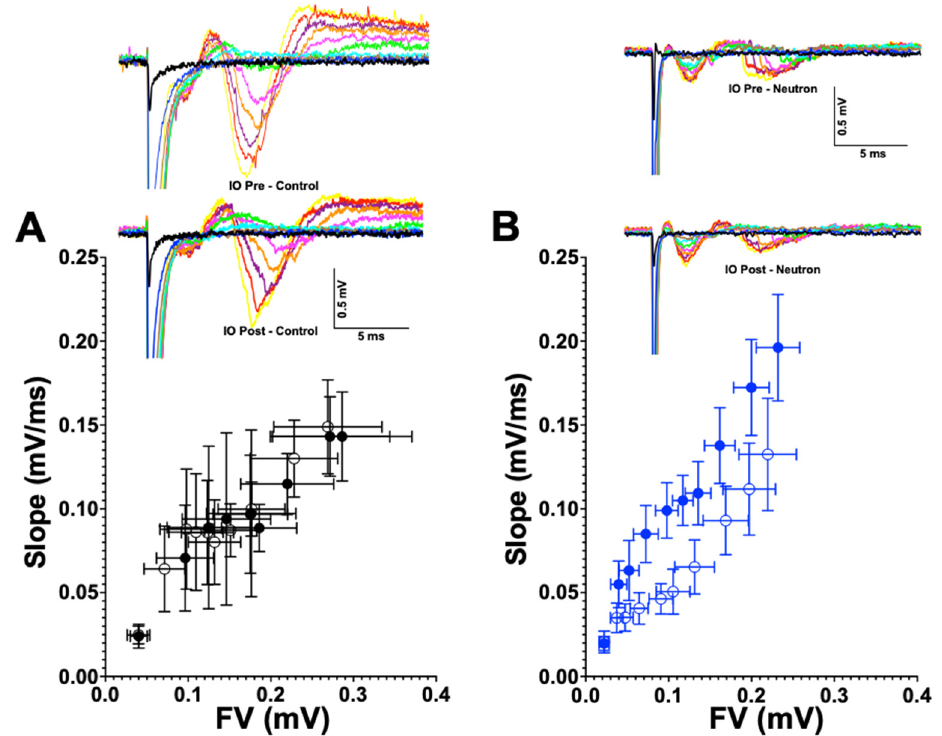
Figure 9. Input-output curves are not altered between the control and the chronic low dose neutron-irradiated group. ( A ) Pre-(filled circles) and post-LFS input-output relationships (clear circles) for the control group are plotted as a function of slope (mV/ms) on the y-axis and the fiber volley (mV) along the X-axis to estimate whether there are changes in the synaptic strength of the response, which would be observed in the either the leftward or rightward shift of the post curves. Representative curves are provided adjacently, where increasing stimulation currents are plotted in different colors. ( B ) Pre (filled blue circles) and post-LFS (clear blue circles) input-output relationship for the neutron irradiated group do not show significant differences. Representative curves are presented alongside, similar to the control group.